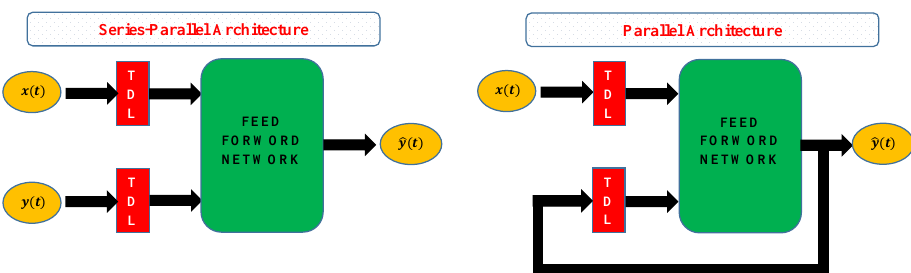
Figure 3. Architectures of the NARX neural network.